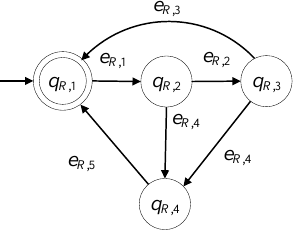
Figure 6. State diagram of